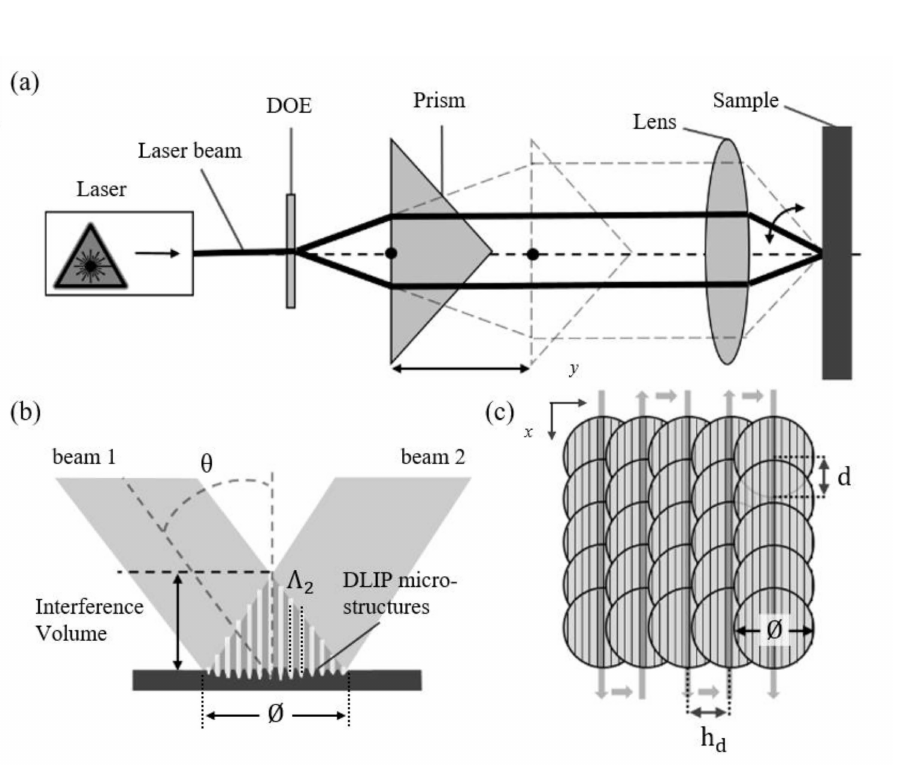
Figure 1. ( a ) Schematic representation of DLIP optical setup; ( b ) schematic view of the interaction zone (with a diameter Ø) of two beams intercepting at angle 2 θ and forming an interference pattern with a particular period of Λ 2 ; ( c ) distribution of pulses during the DLIP process: Ø, d, and h d denote the laser beam diameter (at level 1 / e 2 ), pulse overlap, and hatch distance,